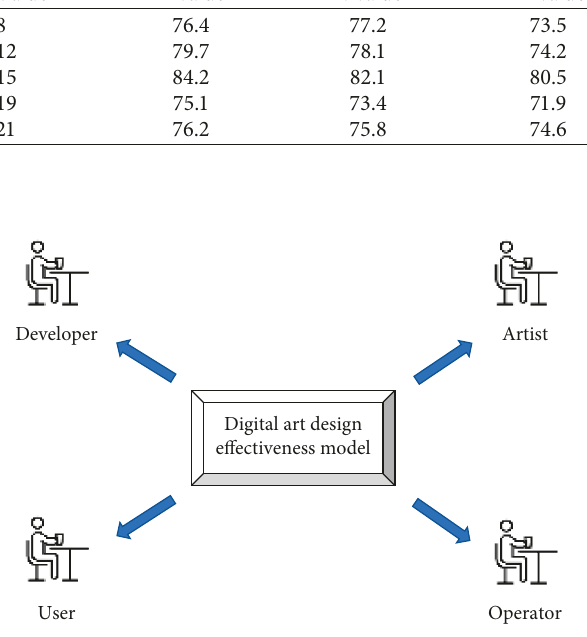
Figure 6: Four main role objects in the digital art design effec- tiveness